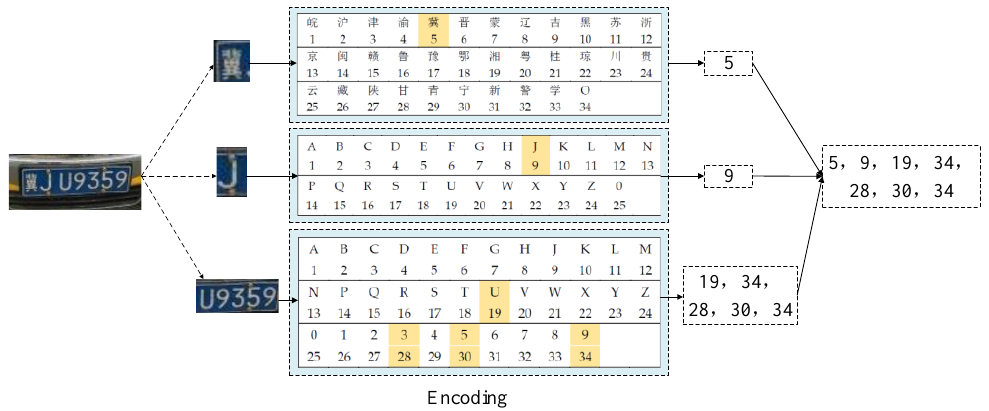
Figure 1. Chinese license plate encoding process. The first encoding character identifies Chinese province. The second encoding character identifies city.